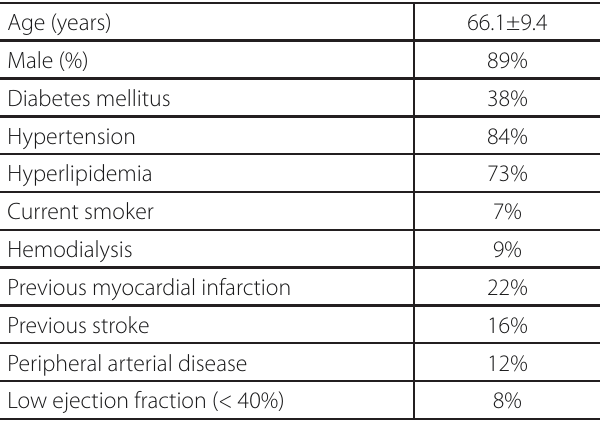
Table 1. Patients’ profiles.